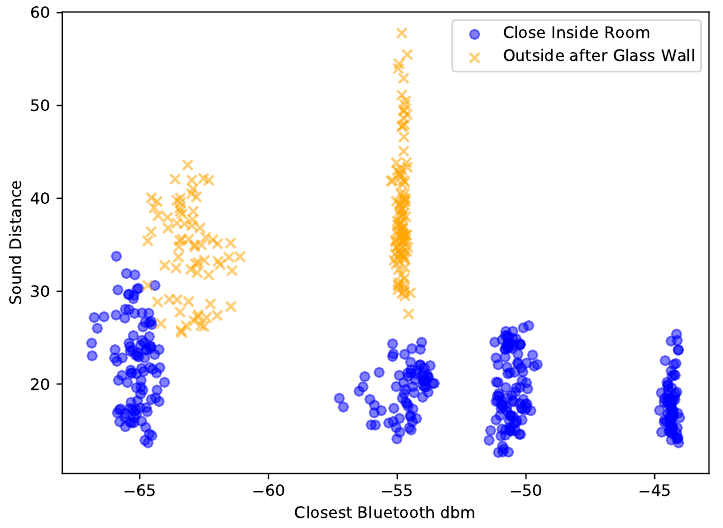
Figure 6. Distribution of features for all our 5 s windows that had acceptable sound for our wall